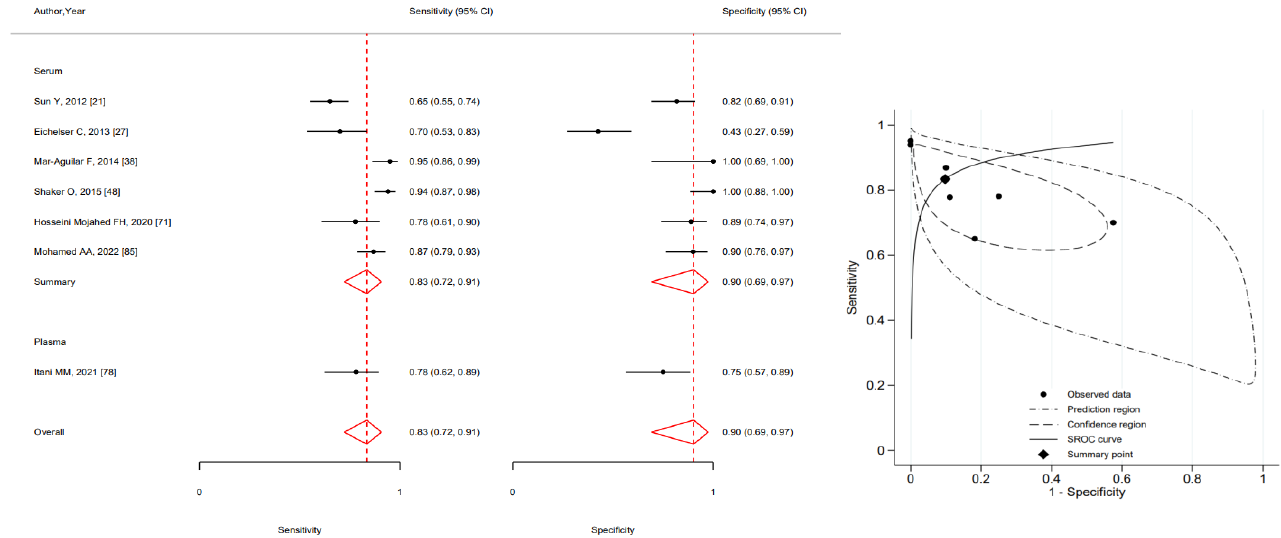
Figure 4. Forest plot of included studies assessing the sensitivity and specificity by type of specimen and summary receiver operating characteristic curve (SROC) of MIR155 in breast cancer diagnosis (squares shows sensitivity and specificity, respectively; red diamonds show pooled effect; error bars represents 95% confidence interval). [21,27,38,48,71,78,85].